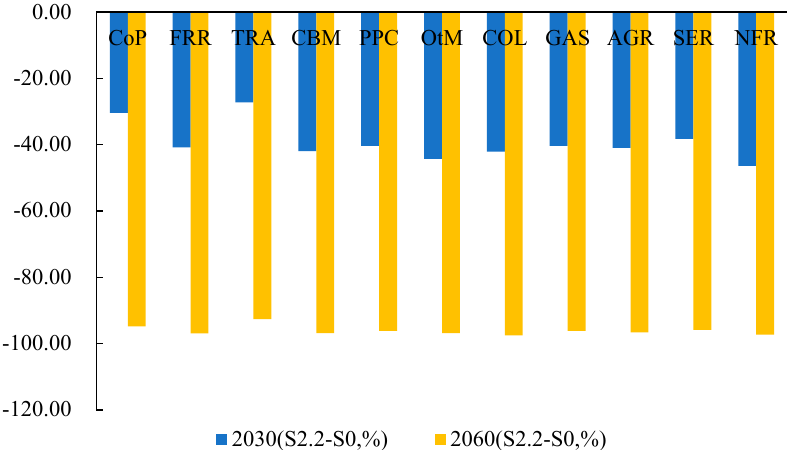
Figure 8. CO 2 emission percentage change of 11 major sectors in 2030 and 2060, China. Note: TRA includes ATR, RTR, HGW and OTR; CBM includes CST and BLD; PPC includes OIL and PNC; OtM includes all other manufacturing sectors except above sectors; SER includes all services sectors.